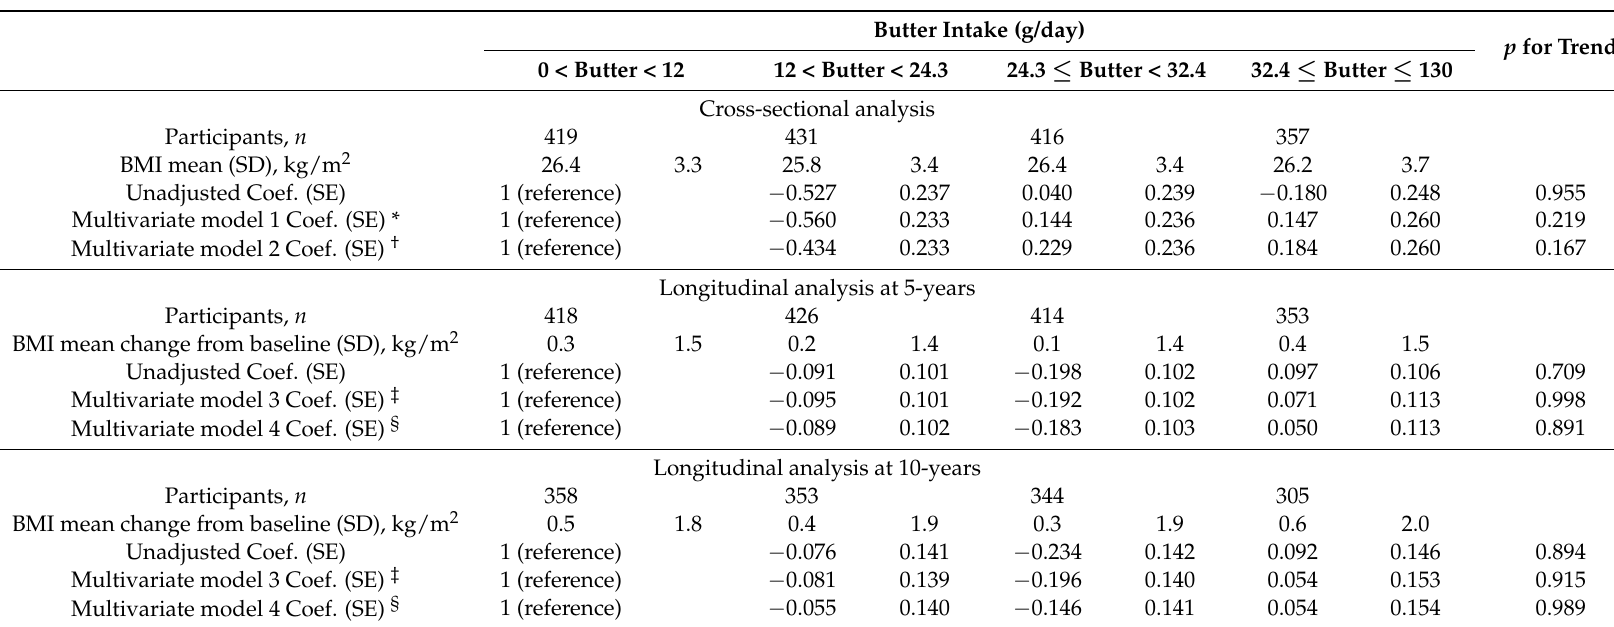
Table 6. Cross-sectional analysis of BMI at baseline and longitudinal analyses over 10-year of BMI changes from baseline by quartile of butter intake. Butter Intake